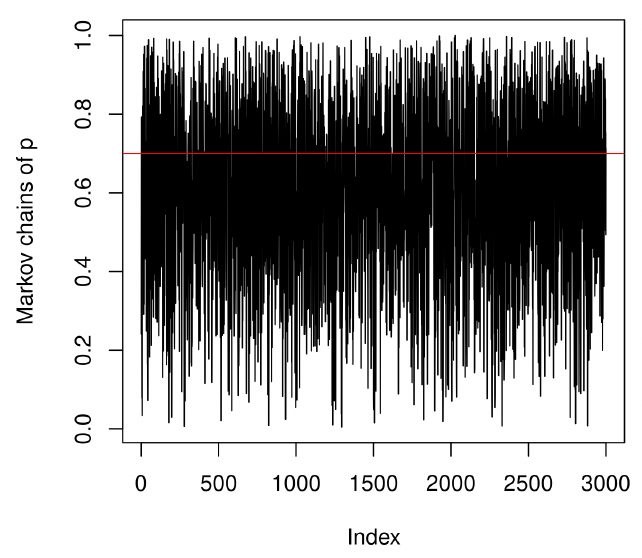
Figure 5. The Markov chains of p . The horizontal line is the true value of p